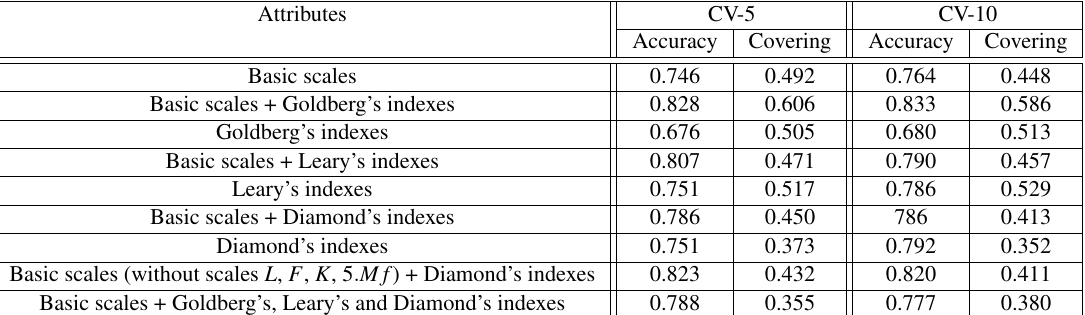
Table 5: Results of experiments using the covering algorithm